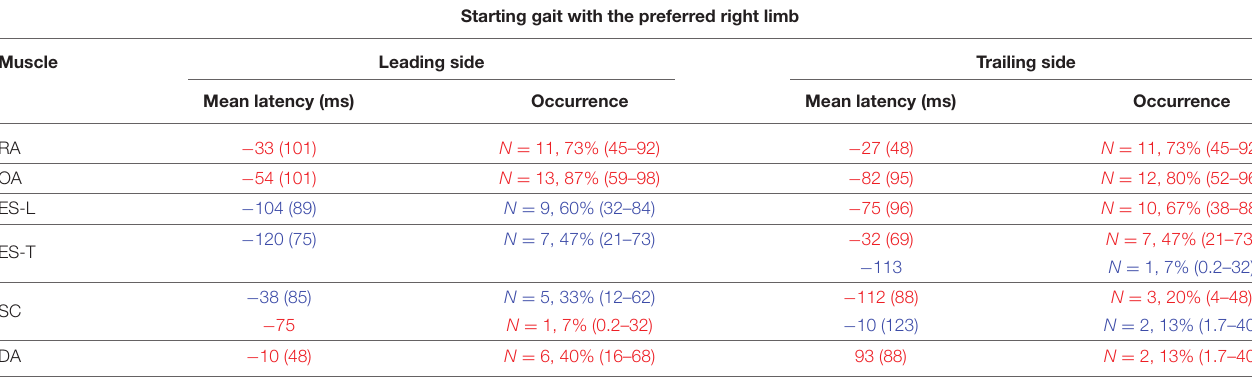
TABLE 1 | Mean latency of anticipatory postural adjustments (APAs) with SD (in parentheses) for each postural muscle when starting gait with the preferred limb. Starting gait with the preferred right limb